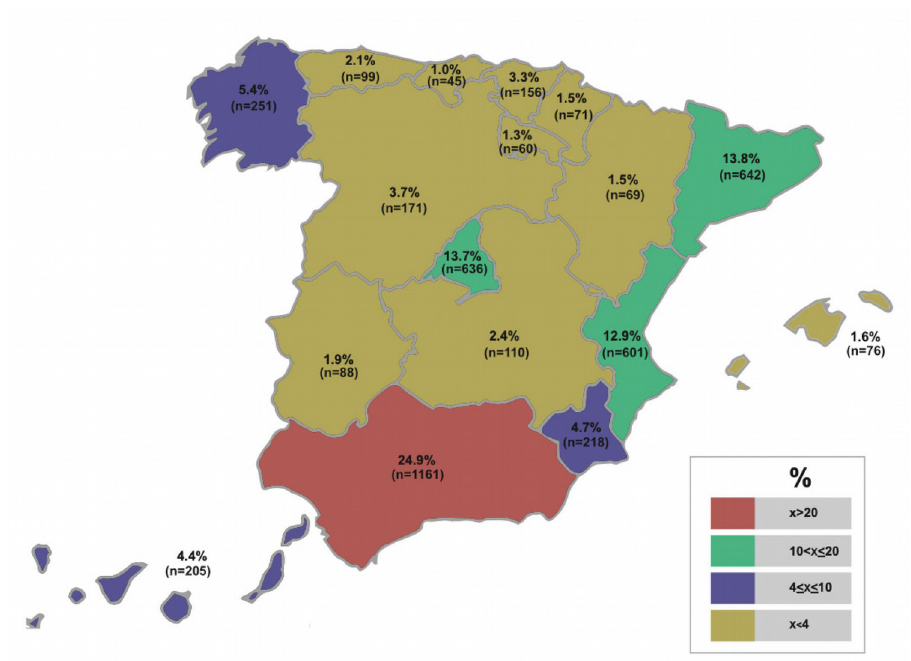
Figure 1. Percentages and frequencies of the sample according to the Autonomous